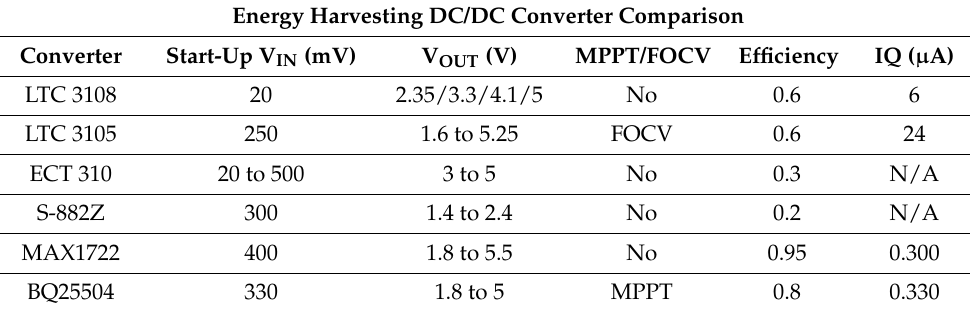
Table 5. Energy harvesting low power direct current DC/DC converter